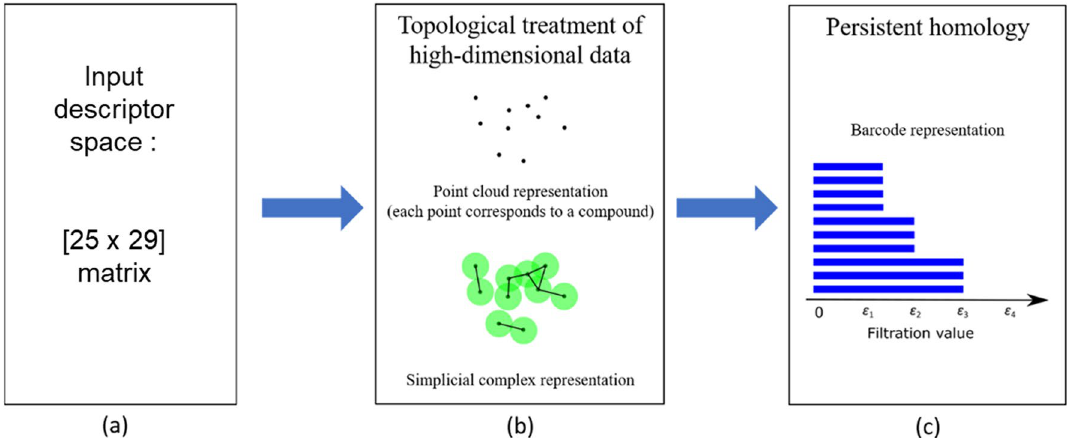
Figure 2. ( a ) The application of the TDA requires input descriptors, such as listed in Table 1, which creates, ( b ) the high-dimensional input space point cloud. Each data point in the point cloud representation of the descriptor space corresponds to an apatite compound. The ‘growing’ disc (highlighted by the green disc centered at each data point) results in formation of multiple topological features such as connected components. ( c ) The evolution of the topological feature is tracked using the barcode representation. The actual barcode for the apatite dataset is provided in Supplementary